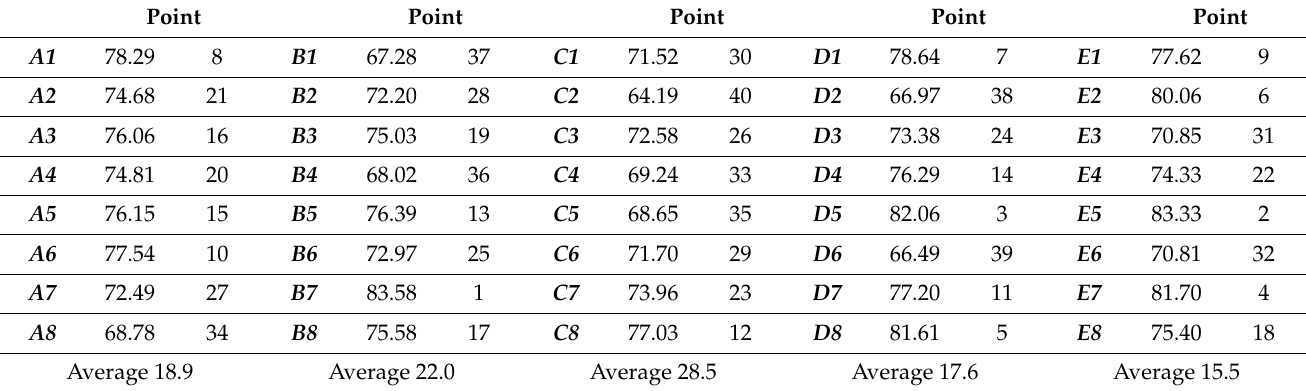
Table 6. Improvement ratio indices on cylinders manufactured with different technologies for R a